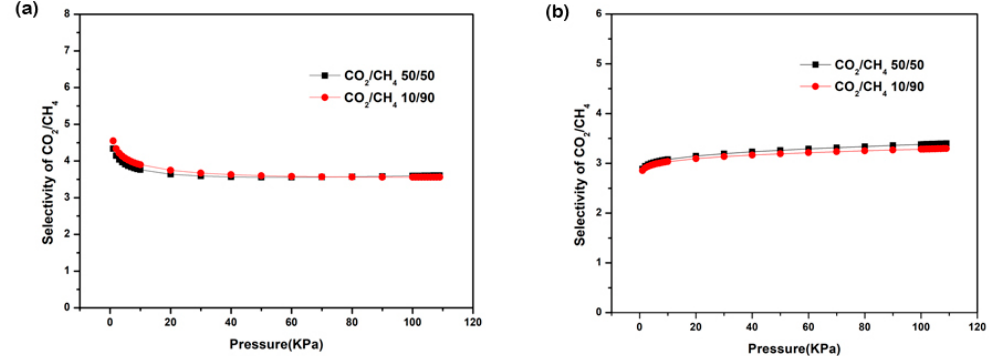
Figure 8. Selective gas adsorption for complex 1 . The CO 2 /CH 4 sorption isotherms for complex 1 at 273 K ( a ) and 298 K ( b ) calculated by the IAST method for two CO 2 concentration.